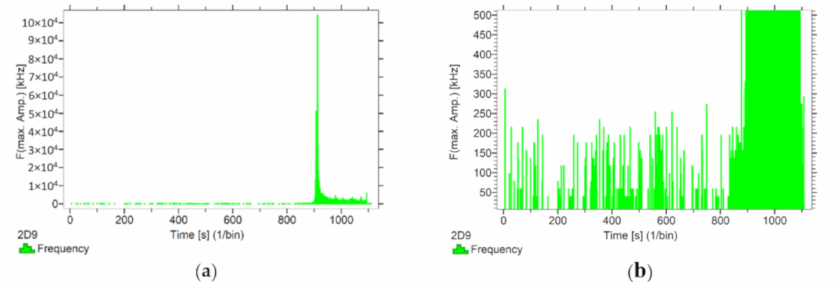
Figure 8. Frequency distribution graph during the test of the mock BS sample: ( a ) taking into account the entire frequency range; ( b ) specifying the frequency range before